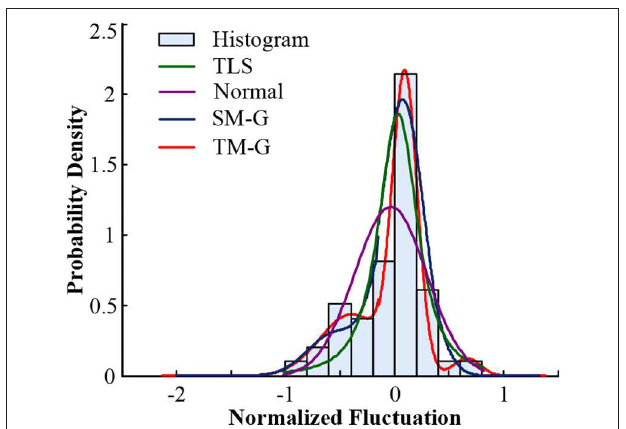
FIGURE 6 | Comparison of probability distribution of volatility components in Xichang City on July 20, 2018.